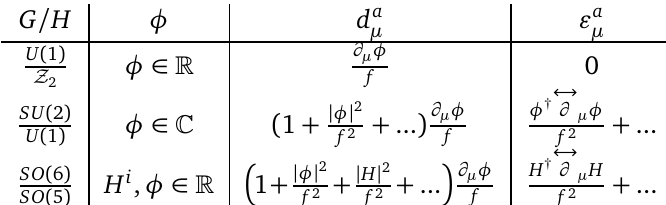
Table 1: Building blocks for the effective Lagrangian with different SSB patterns. Dots denote higher order terms in 1 / f